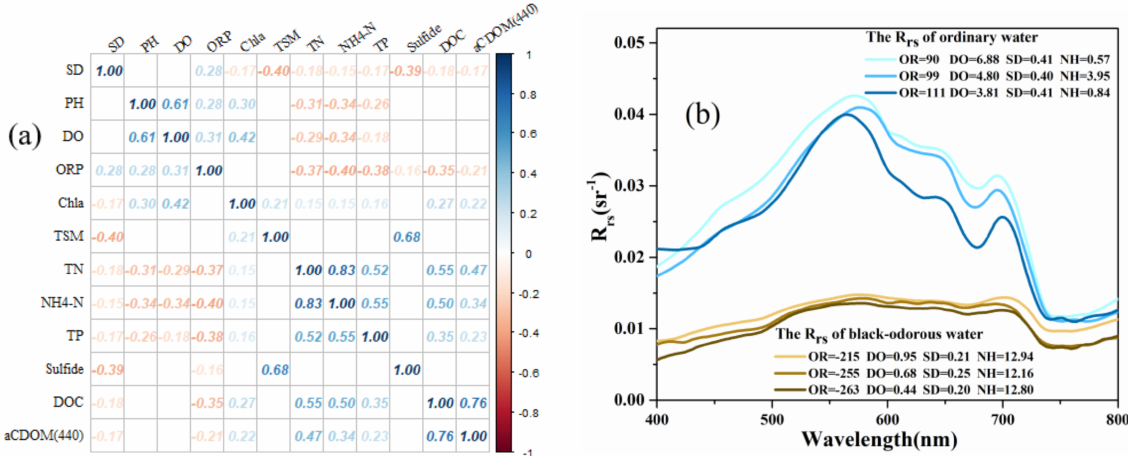
Figure 9. Pearson correlation coefficient matrix between 12 water quality parameters, only showing the Pearson correlation coefficient when p < 0.05 ( a ), and typical R rs values of black-odorous water and ordinary water ( b ). OR: ORP (mV); DO: DO concentration (mg/L); SD: SD (m); NH: NH 4 -N